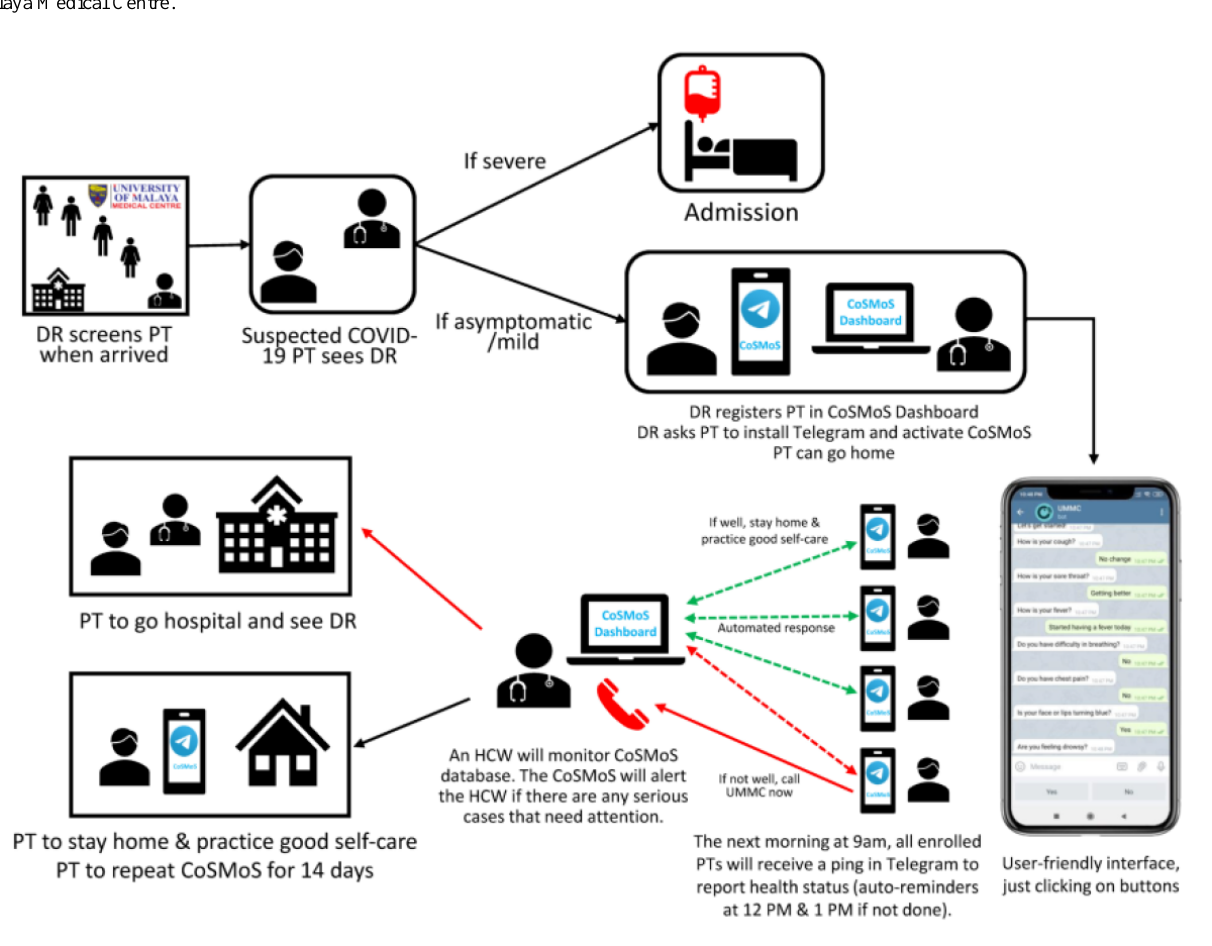
Figure 1. COVID-19 Symptom Monitoring System (CoSMoS) storyboard. DR: doctor; HCW: health care worker; PT: patient; UMMC: University of Malaya Medical